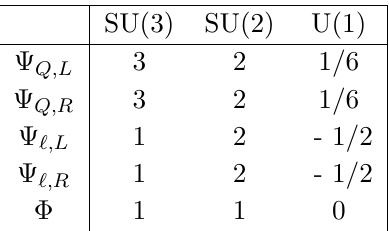
Figure 1 . Box-diagrams contributing to (a) b ! s(cid:22) + (cid:22) (cid:0) and (b) B s ! (cid:22) B s , with couplings given in eq. (2.1).